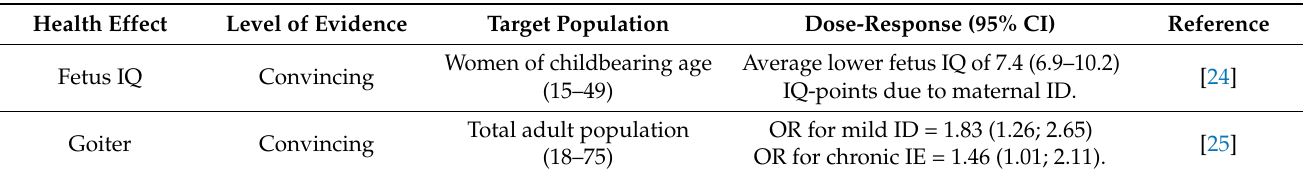
Table 1. Health effects associated with iodine deficiency (ID) and iodine excess (IE), graded level of evidence, target population, and identified effect sizes for each